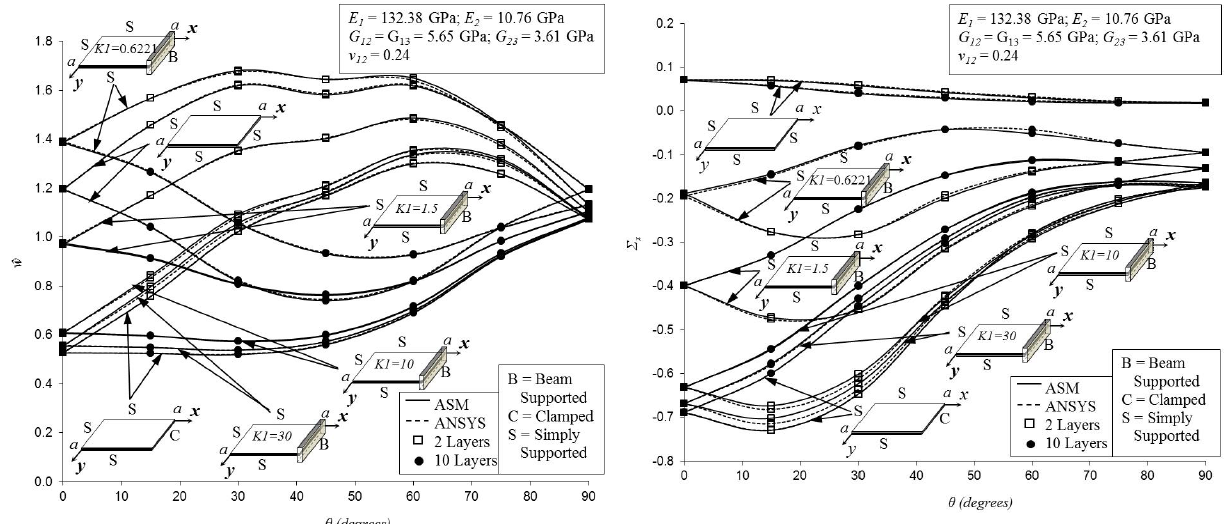
Figure 3: Influence of the beam stiffness, K1 , and ply orientation angle, θ , on the stress Σ x (︀ 0.975 a , a 2 )︀ = (︁ 100 E )︁ 2 h 3 w , at the center a 4 q